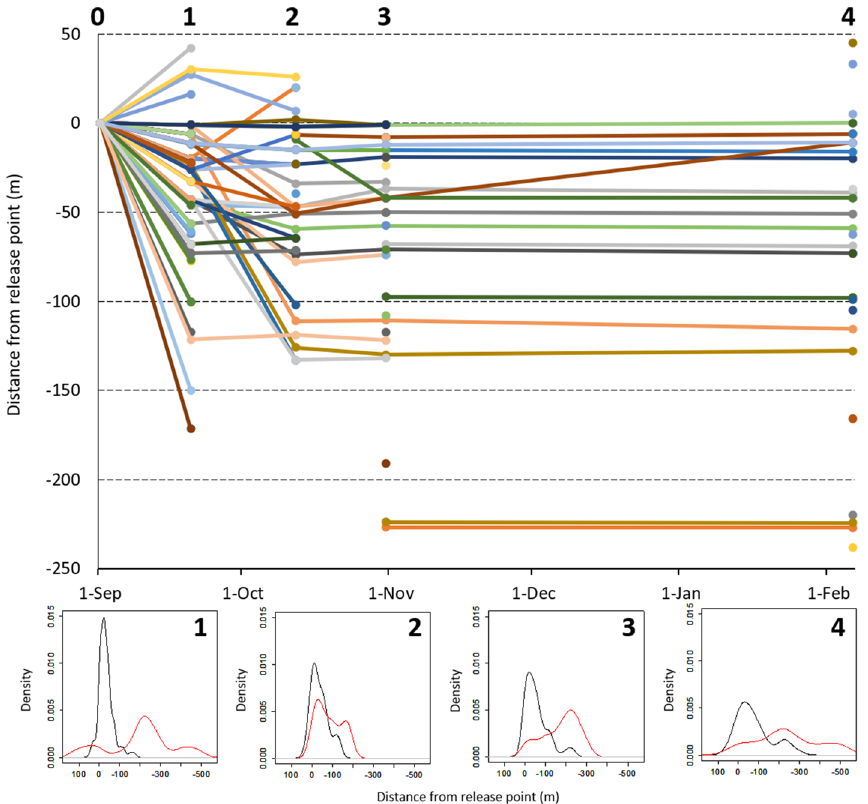
Figure 3. Evolution of individual dispersal distances during the experimental period (158 days). Frequency graphs (1, 2, 3 and 4) were performed by using Kernel interpolation; frequencies of experimental and wild fish are indicated by black and red lines, respectively (0: time at release; 1: 19 days later; 2: 41 days, 3: 60 days; 4: 158